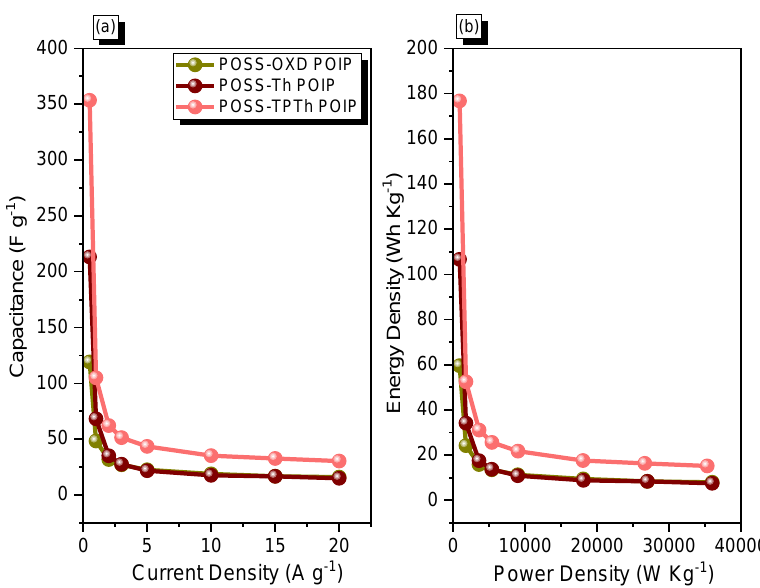
Figure 8. ( a ) Capacitance and ( b ) Ragone plots for the POSS-OXD, POSS-Th, and POSS-TPTh POIPs.